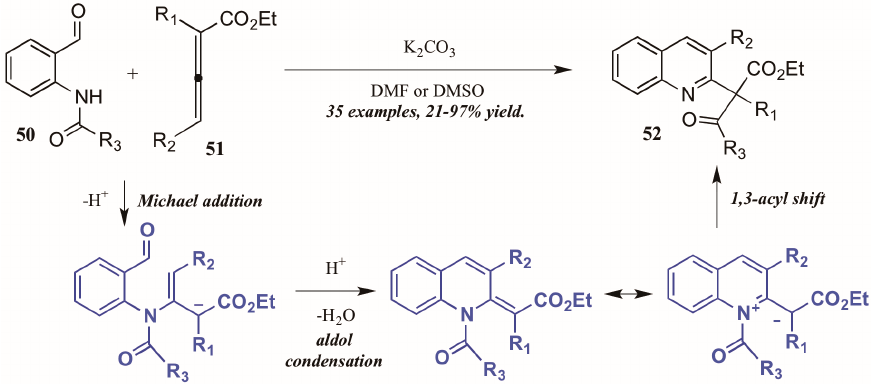
Figure 23. Base-mediated cyclization of 2-aminobenzaldehydes with allenoates.